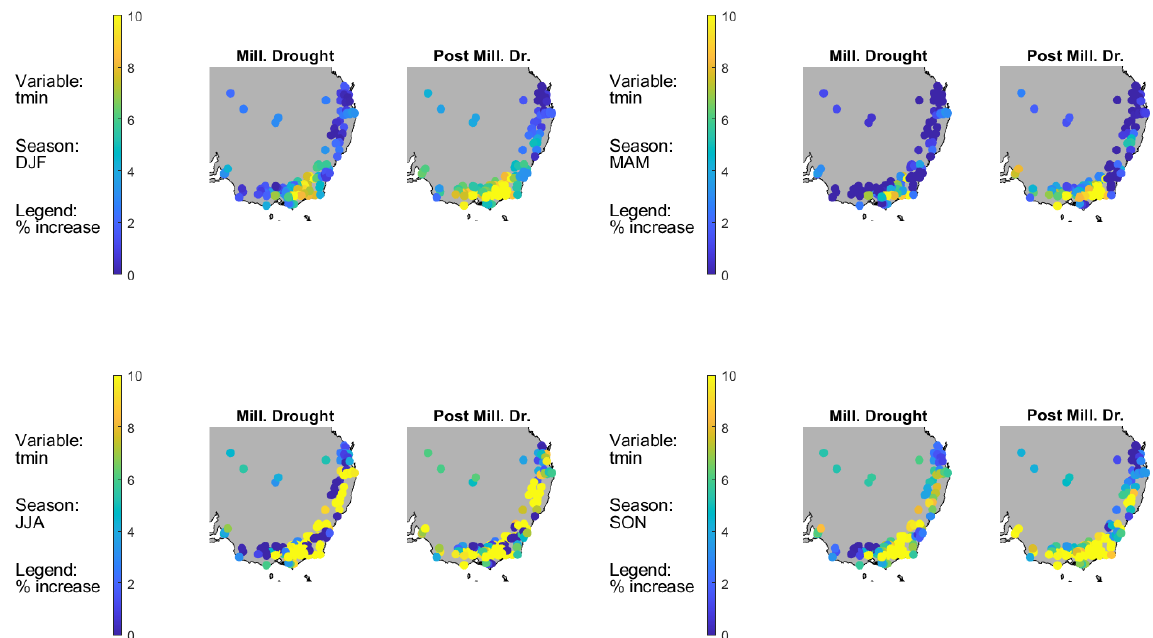
Figure D6. Same as Fig. D1 except for t min (minimum daily temperature). Based on data from Fowler et al. (2021).